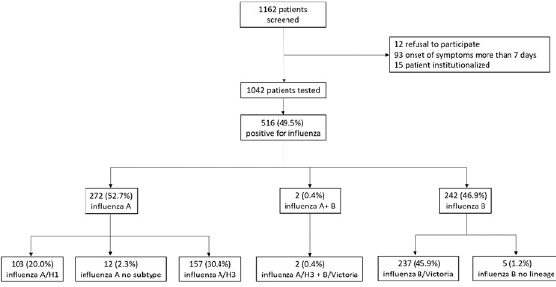
Fig 1. Study design flowchart. Percentages of influenza types and subtypes were calculated relative to the total number of influenza positive cases.